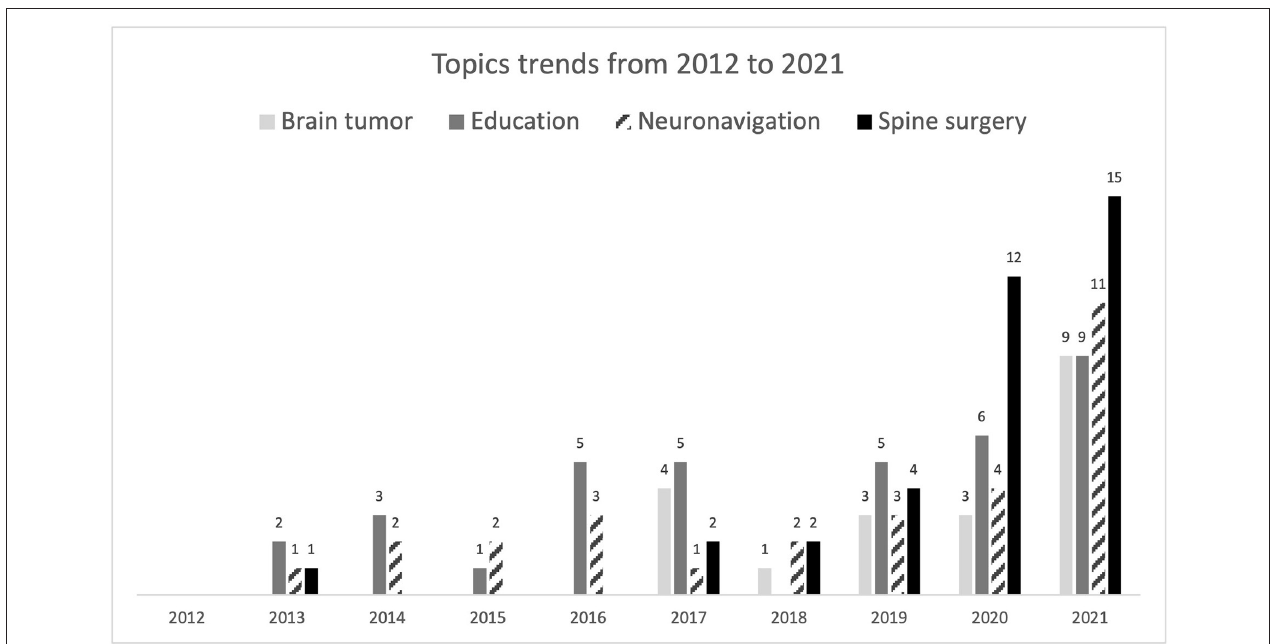
FIGURE 7 | Diagram representing the topics trends per year.